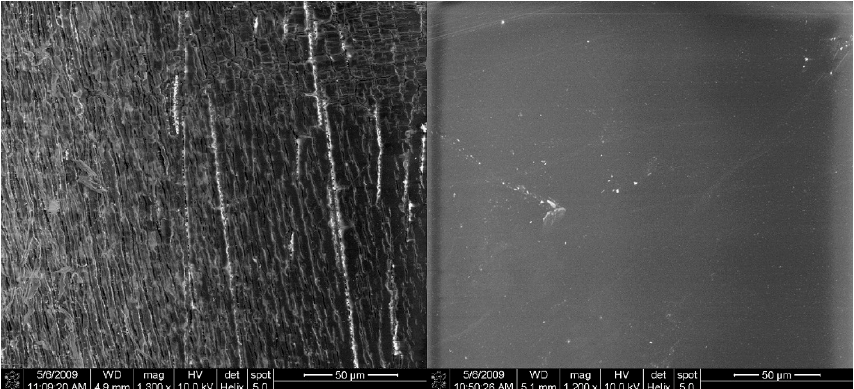
Figure 3. SEM micrographs of the surface of Upilex25S film after (left) and before (right) being incubated in PBS at 85 °C for 18 months. Reproduced from [29], with permission from © 2010 Elsevier.